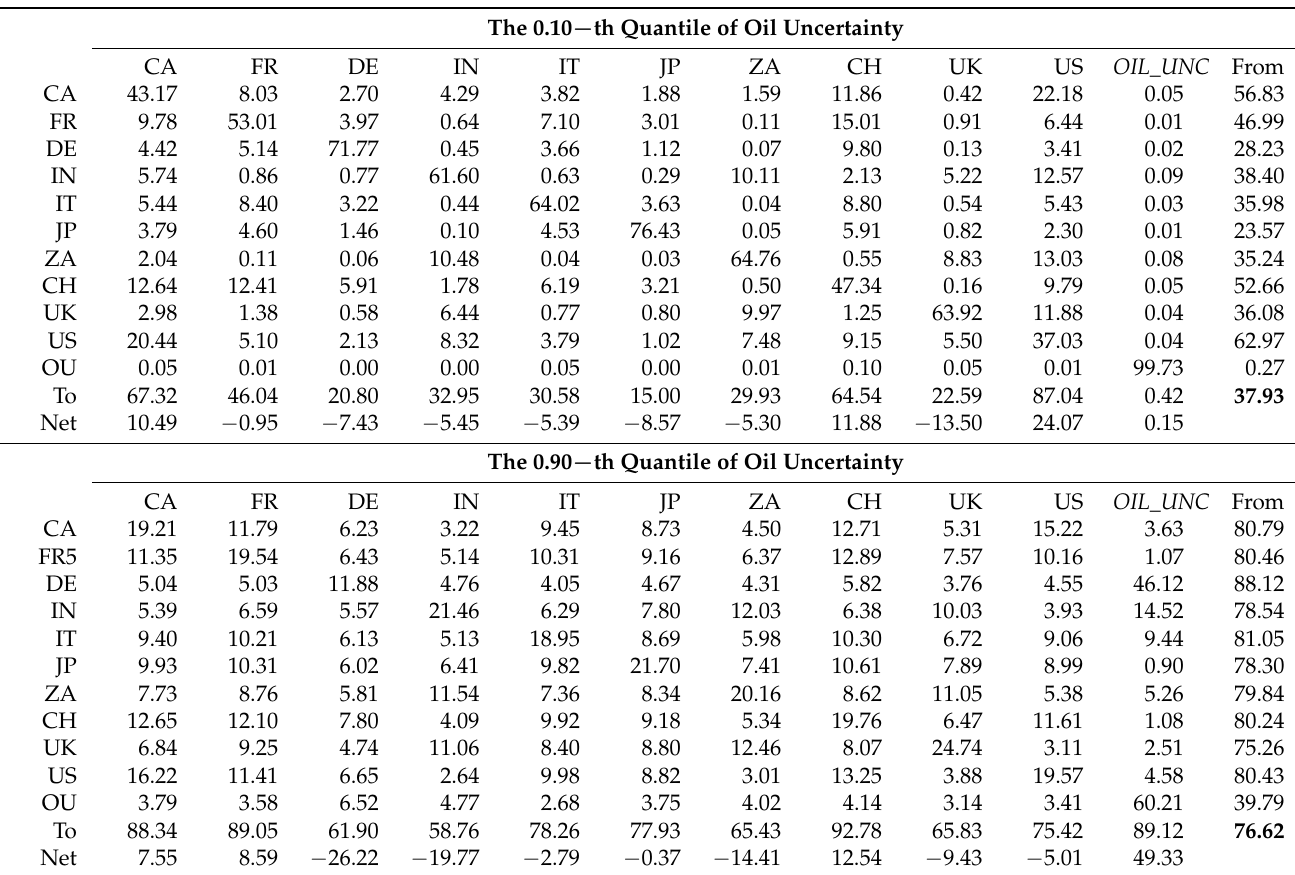
Table A7. Regime dependent connectedness based on the QVAR